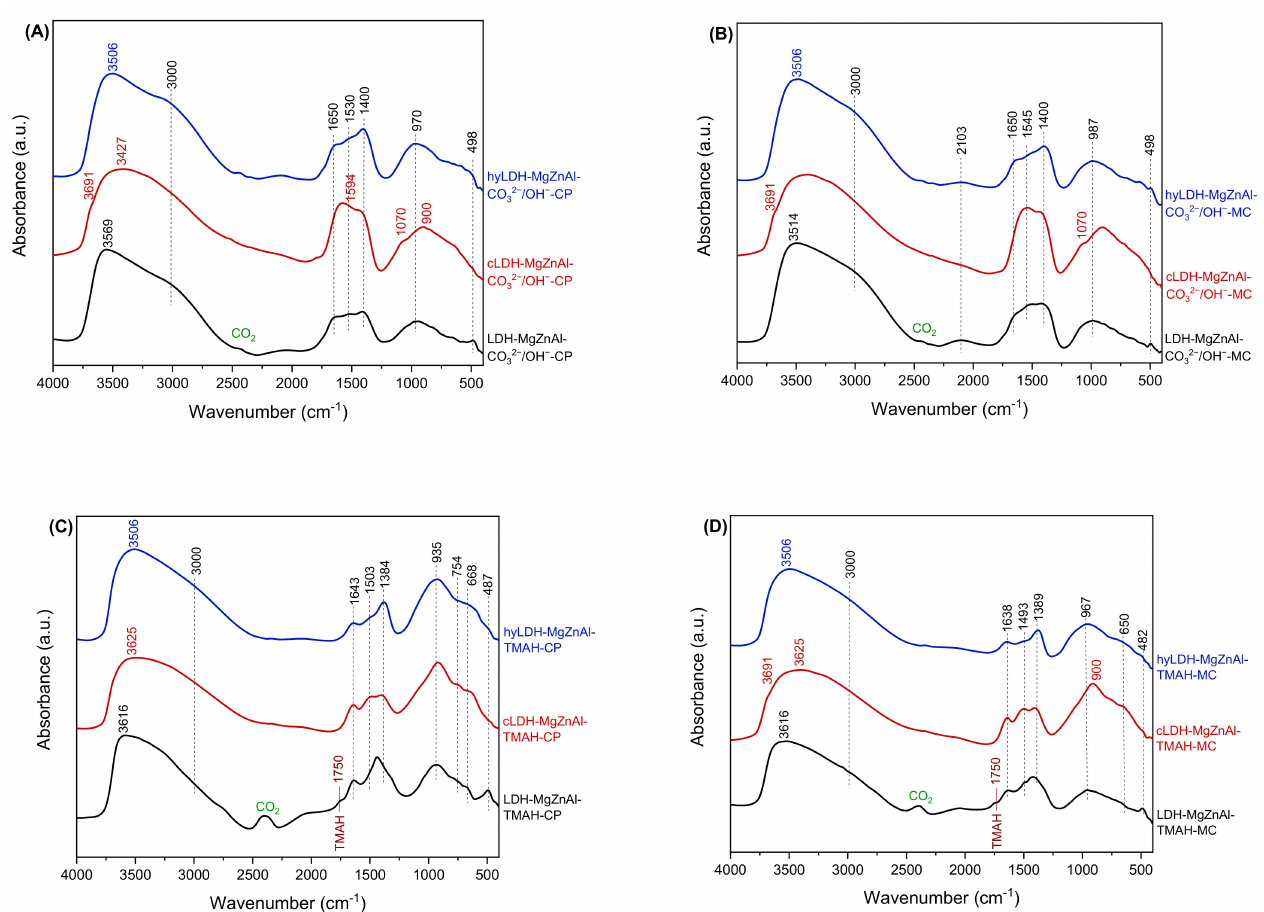
Figure 2. DRIFT spectra of the materials synthesized though ( A ) co-precipitation and ( B ) mechano- chemical method, both in the presence of Na 2 CO 3 /NaOH, as well as ( C ) co-precipitation and ( D ) mechano-chemical method, both in the presence of